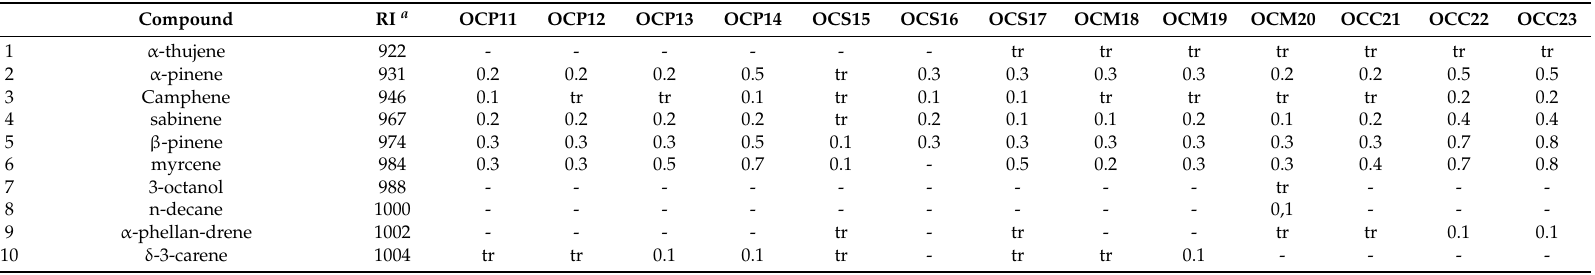
Table 3. Chemical composition of the essential oils from O. basilicum L. varieties latifolia, minimum, lettuce and cinnamon, cultivated in the field